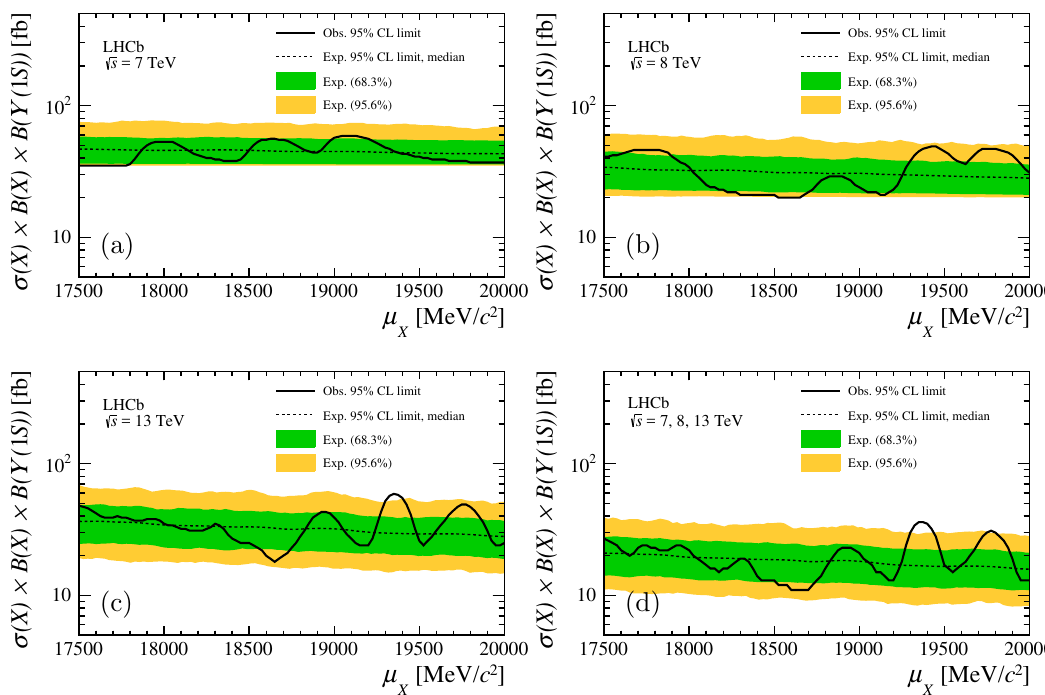
Figure 4 . The 95 % CL upper limits on S (cid:17) (cid:27) ( pp ! X ) (cid:2)B ( X ! (cid:7) (1 S ) (cid:22) + (cid:22) (cid:0) ) (cid:2)B ( (cid:7) (1 S ) ! (cid:22) + (cid:22) (cid:0) ) as functions of the X mass hypothesis at pp centre-of-mass energies of (a) 7 TeV, (b) 8 TeV and (c) 13 TeV and (d) all